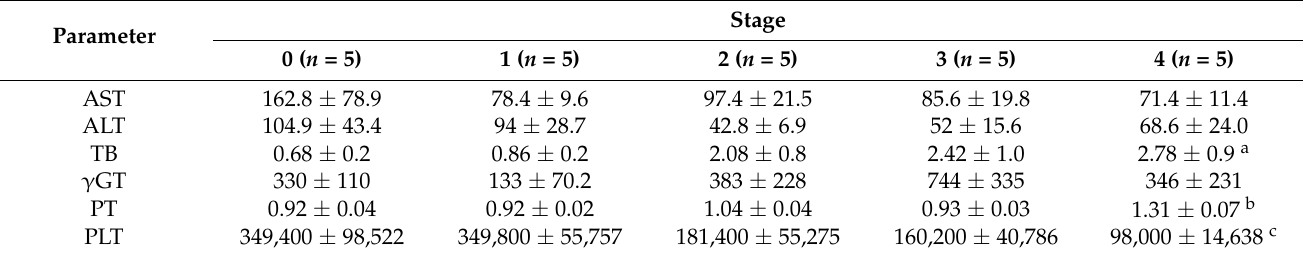
Table 1. Liver function test in fibrotic human livers.